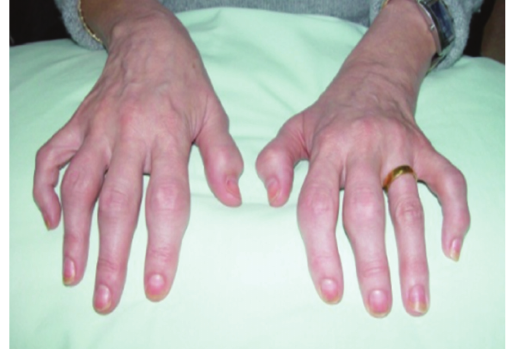
Figure 1: Symmetric polyarticular psoriatic arthritis a ff ecting all the proximal interphalangeal joints of the fingers except the left ring finger PIP joint which seems to be protected by wearing a golden ring. Psoriatic nail changes are also evident in this photo.